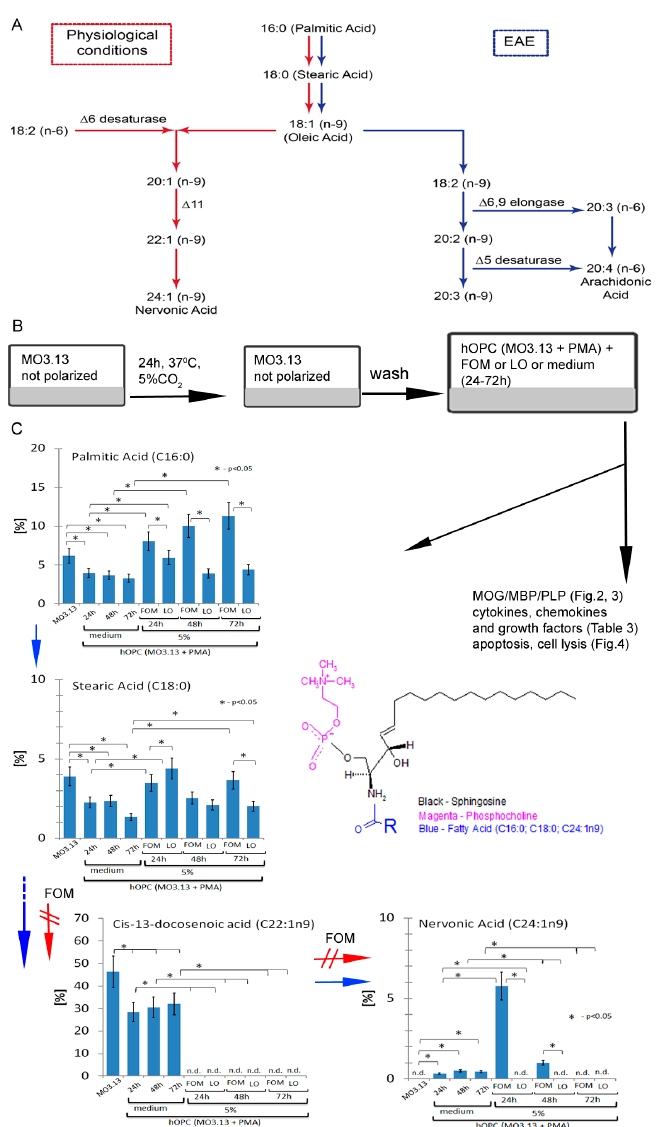
Figure 1. Human oligodendrocyte precursor cells (hOPCs) incorporate and metabolize nervonic acid. ( A ) GC / MS lipid profiling of the whole brain tissue revealed that nervonic acid (NA) ester (red arrows) is not synthetized during EAE in contrast to arachidonic acid ester (blue arrows) known for its proinflammatory properties. ( B ) Human phorbol 12-myristate 13-acetate (PMA)-stimulated MO3.13 cells, as the cellular model of oligodendrocyte progenitor cells (OPC) polarization to mature myelin-producing oligodendrocytes, were used to determine an e ff ect of fish oil mixture (FOM) supplementation on OPC function. LO was used as the negative control. PMA-stimulated MO3.13 cells were incubated with 5% FOM or 5% LO for 72 h. (C middle right panel) Sphingomyelin consists of a phosphocholine head group, sphingosine, and fatty acid esters which are bound via an amide bound to a sphingosine base [31,34]. Fatty acid esters were detected by the GC / MS method. ( C ) NA, opposite to palmitic and stearic acid is synthetized de novo by maturating OPCs. Palmitic and stearic acid esters are constitutively presented in hOPCs, and can be directly used for sphingomyelin synthesis or can also be used as substrates for NA synthesis with cis -13-dicosenoic acid as an intermediate product (blue arrows). During FOM supplementation, NA is directly incorporated by hOPCs, while the cis -13-dicosenoic acid-dependent pathway is inhibited (red arrow). The rates of acid esters were measured at three time points (24 h, 48 h, and 72 h) in lyophilisates of hOPCs incubated with FOM or LO or in medium. Data are presented as means ± SD from four independent